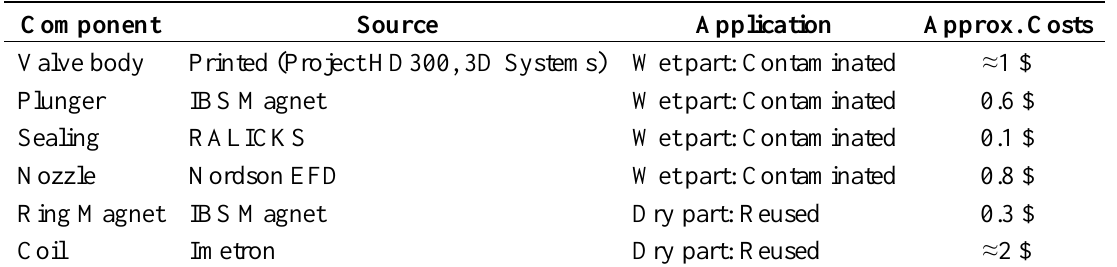
Table 2. List of components of the dispensing valve, including the approximate material costs.